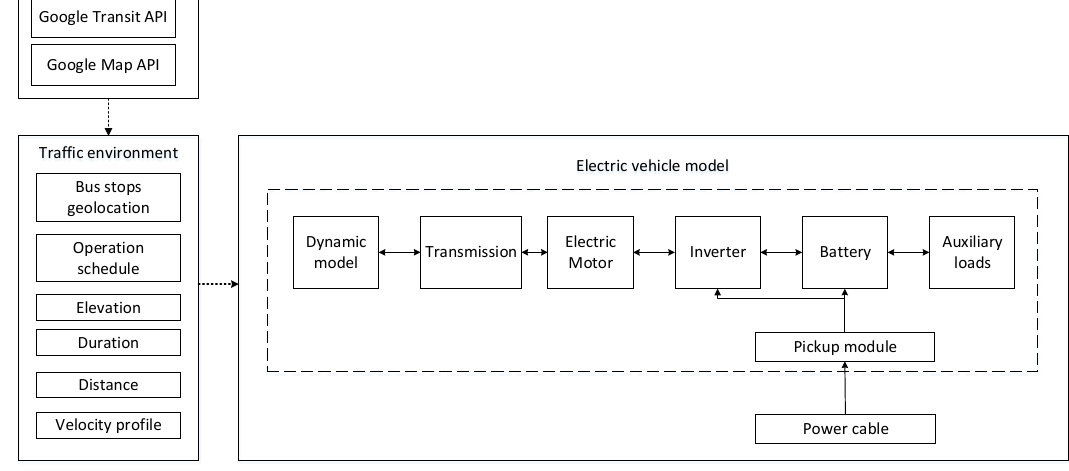
Figure 2. System configuration of wireless charging electric bus